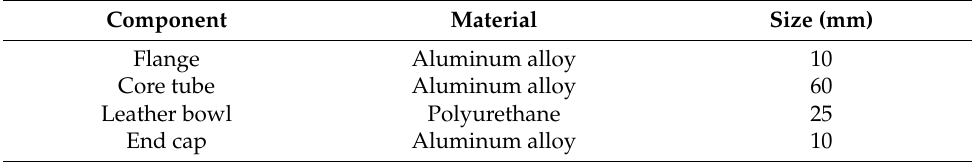
Table 3. Pipeline robot components.